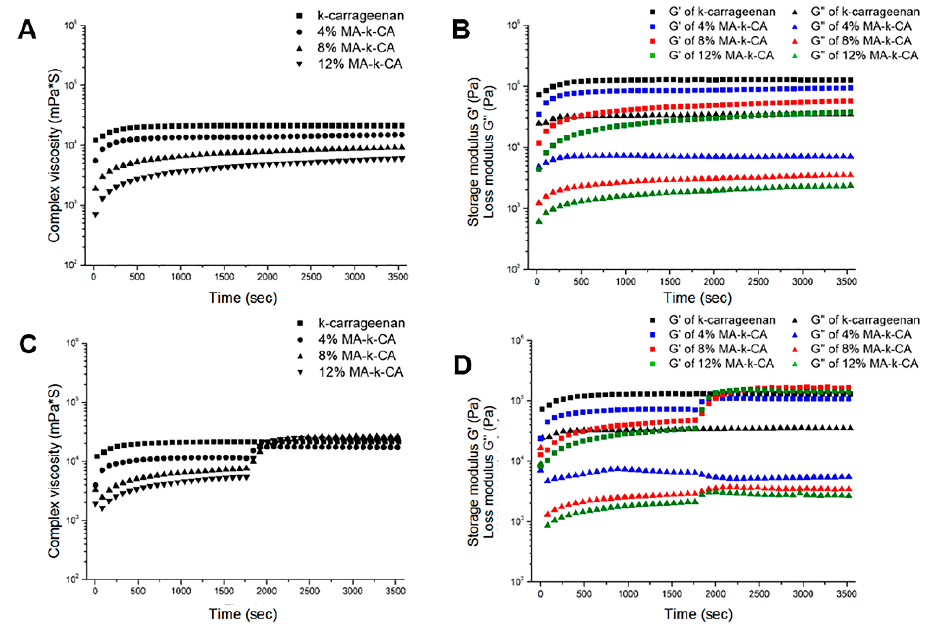
Figure 3. Ionic and UV crosslinking dependent rheological properties. Rheological properties of κ -CA and 4, 8 and 12% MA- κ -CA hydrogel during ionic crosslinking for 1 h (3600 s) ( A ) Complex viscosity ( B ) Storage modulus (G’) and Loss modulus (G”). Rheological properties of κ -CA and 4%, 8%, 12% MA- κ -CA hydrogel during ionic and UV crosslinking for 1 h (3600 s) ( C ) Complex viscosity ( D ) Storage modulus (G’) and Loss modulus (G”).